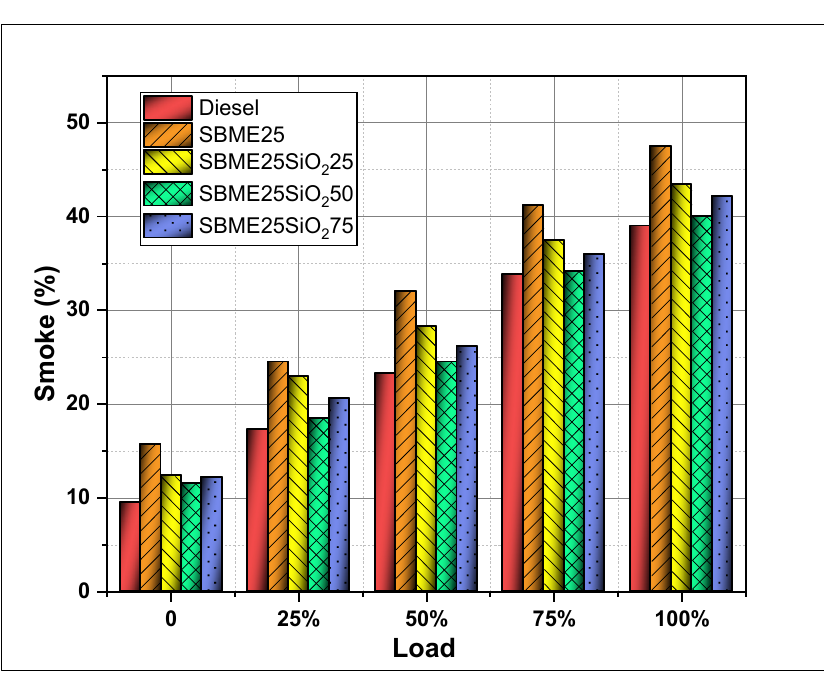
Figure 13. Effect of SiO 2 nano-additive on smoke at varying loads.